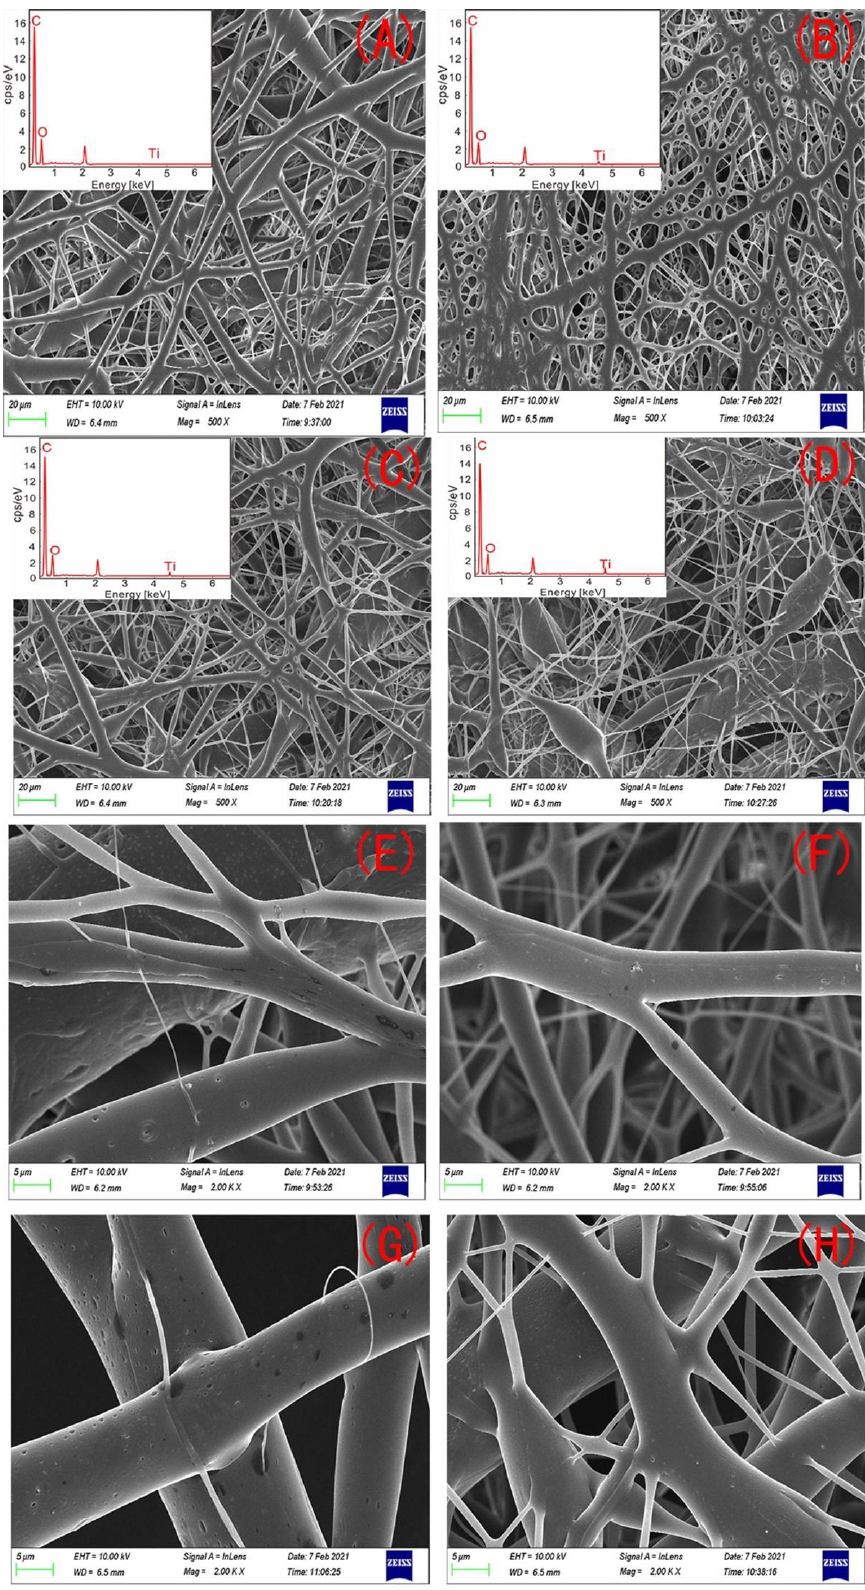
Figure 2. SEM images of PHBV ( A , E ), PHBV—GO/MXene 0.1% ( B , F ), PHBV—GO/MXene 0.5% ( C , G ), and PHBV—GO/MXene 1% ( D , H ) composite membranes. Inset figures show the EDS